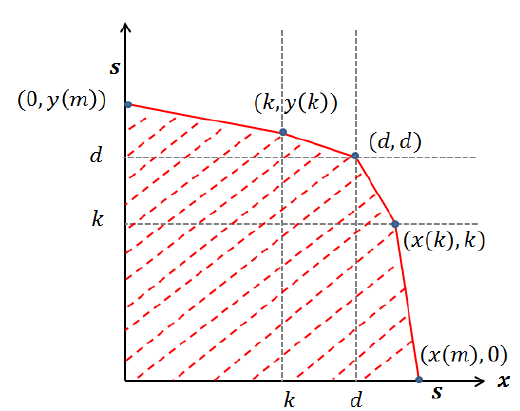
Figure A4. Case k ≤ d